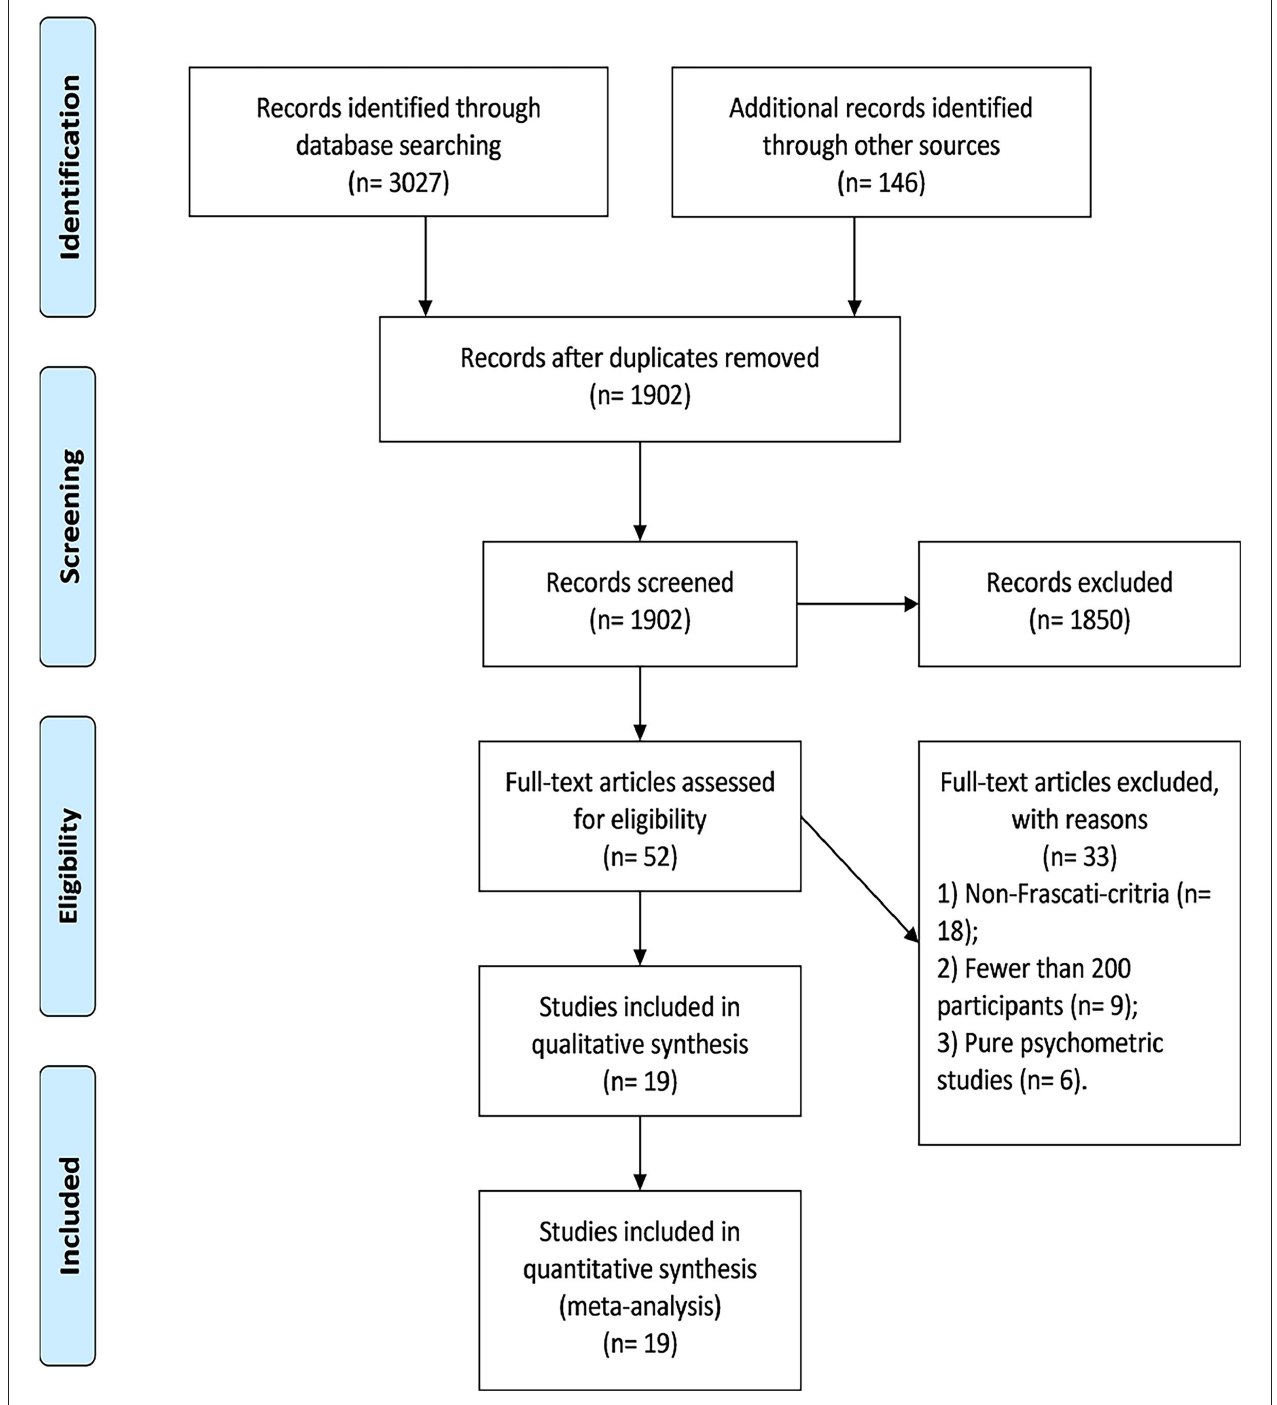
FIGURE 1 | Selection of trials for inclusion of the systematic review and